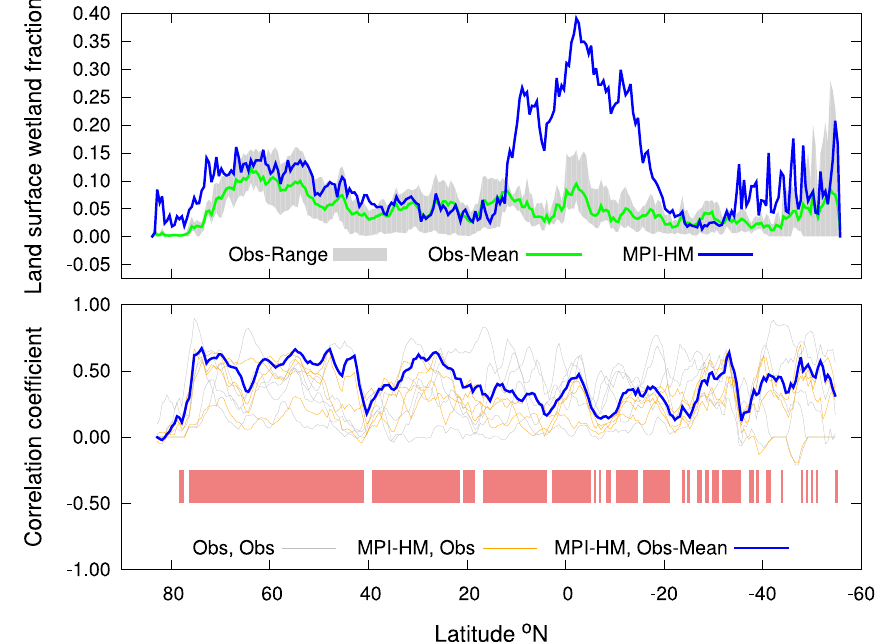
Fig. 6. Top: zonal means of land surface wetland fraction. The grey area indicates the range of the observation datasets, the green curve shows their mean extent and the blue curve shows wetland fractions as simulated by the MPI-HM (blue). Bottom: zonal correlation between the MPI-HM wetland extent and the mean of observations (blue), between the MPI-HM wetland extent and the four observation datasets (orange) and between the observations themselves (grey). Displayed are running means over 2.5 latitudes. The red boxes indicate latitudes where the correlation significance level between the MPI-HM results and mean extent of the observations is above